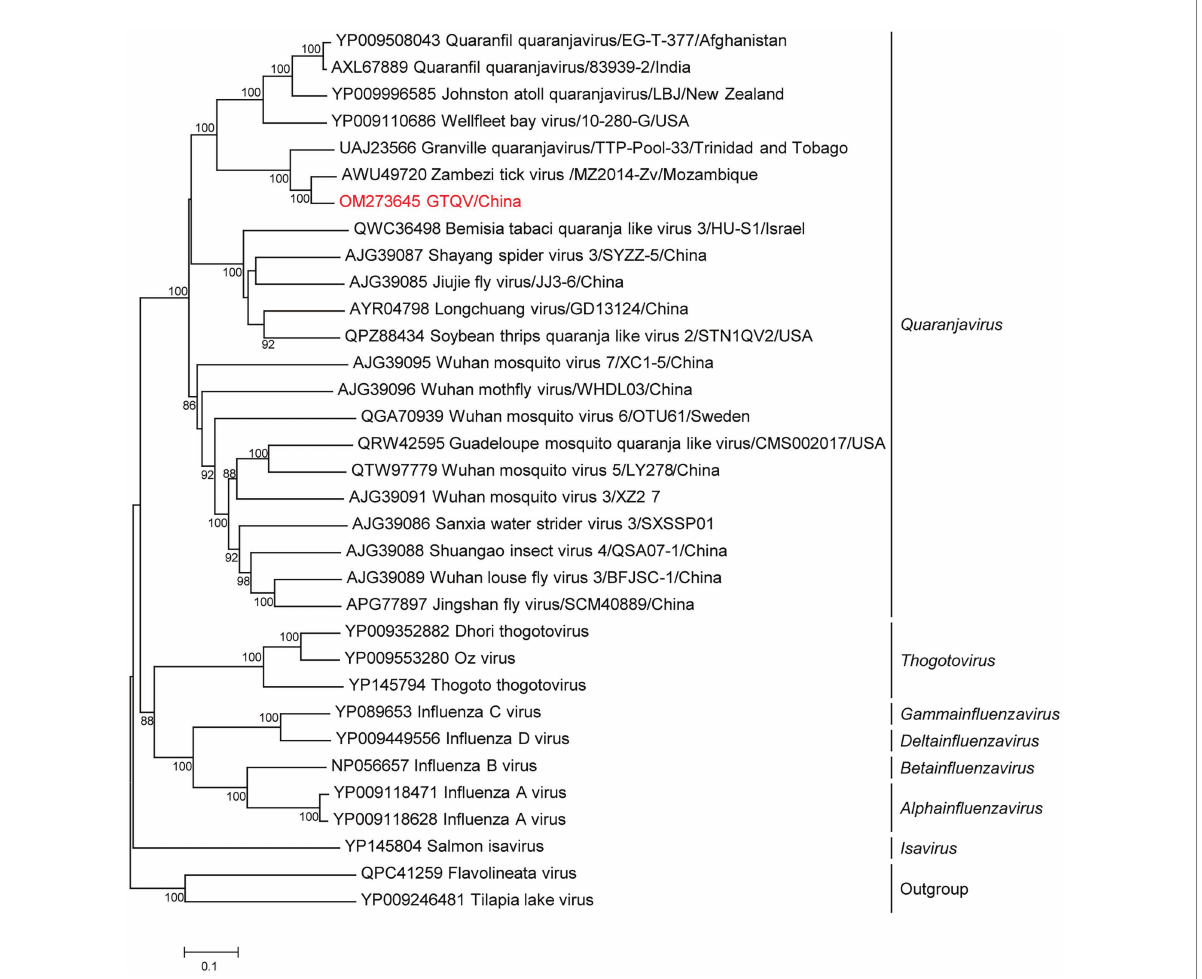
FIGURE 4 Phylogenetic analysis of orthomyxoviruses. Phylogenetic trees of Guangdong tick quaranjavirus (GTQV) were constructed based on the polymerase basic protein 1 (PB1) protein sequences of representative viruses in the family Orthomyxovirus . Viruses obtained in ticks here are highlighted in red. Scale bar indicates nucleotide substitutions per